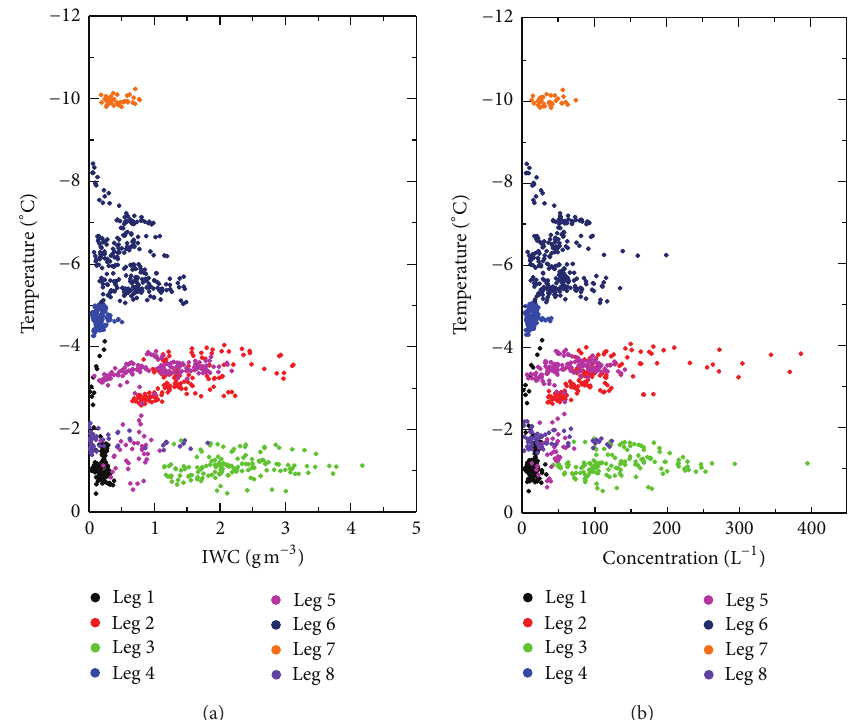
Figure 6: Variation of (a) IWC and (b) ice particle concentrations with temperature for the three cloud